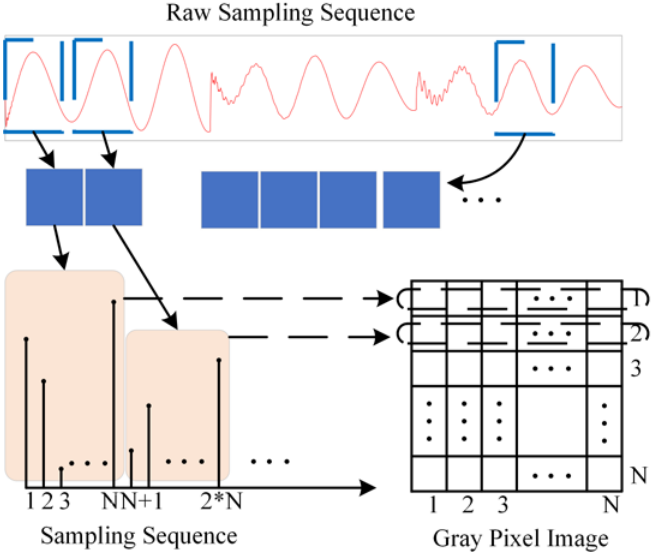
Figure 6. Signal-image conversion method.